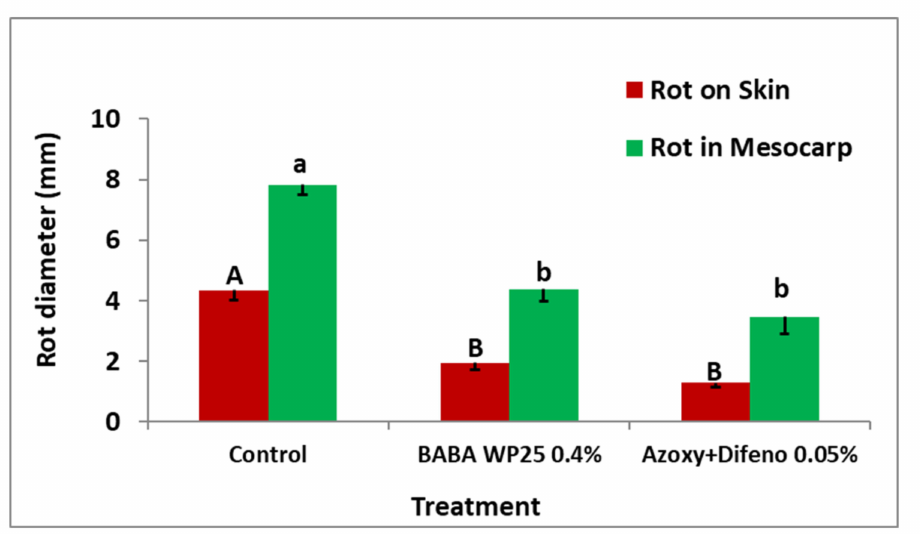
Figure 8. Efficacy of six foliar applications of BABA WP25 and the pre-mixture azoxystrobin plus difenoconazole (Azoxy + Difeno) on rot development in Pink Lady apple fruits in the orchard (Experiment 3). Mean values of lesion diameter on skin (uppercase letters) or in mesocarp (lowercase letters) above columns followed by different letters indicate on significant ( p < 0.05) differences between treatments (Fisher’s LSD t -test). Bars represent the standard error of the